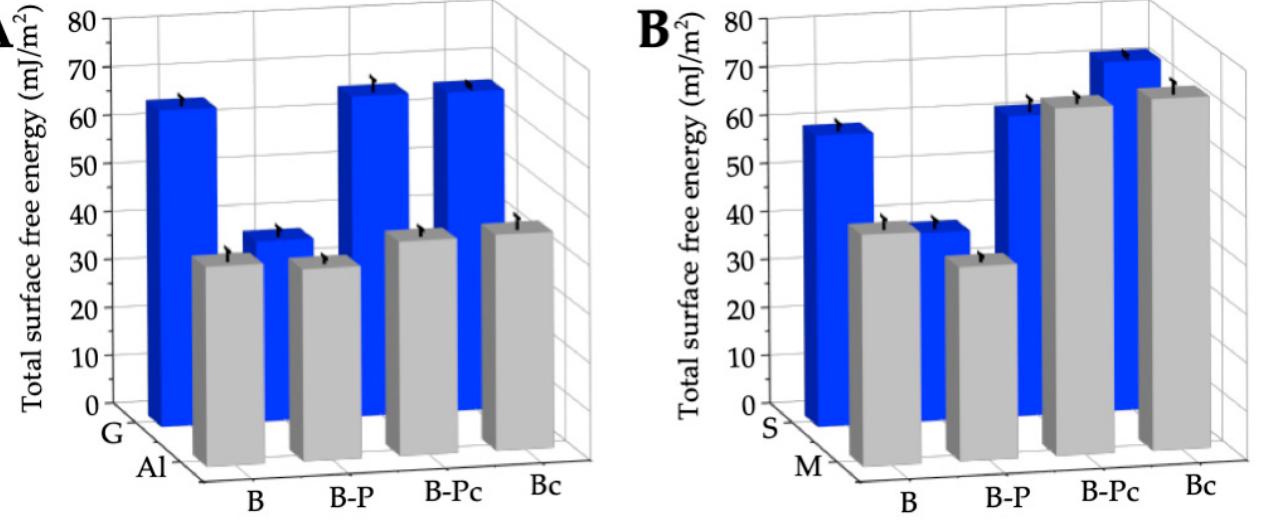
Figure 7. Surface free energy calculated from the CAH approach of bare sensitive surfaces, covered with the paint (B-P), after its removal (B-Pc), and cleaning the bare surfaces with NE No. 10 (Bc). ( A ) The surfaces produced from the man-made materials. ( B ) The surfaces produced from the natural materials.